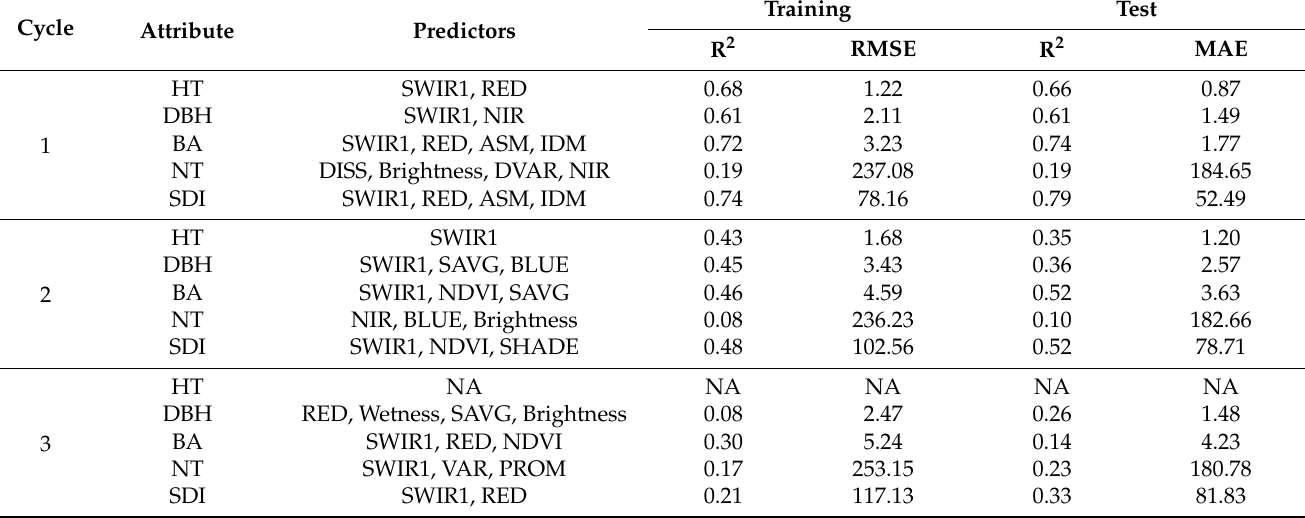
Table 4. Final multiple linear regression models by cycle and attribute including model predictors, model goodness of fit on the training data, and model validation on the test data.